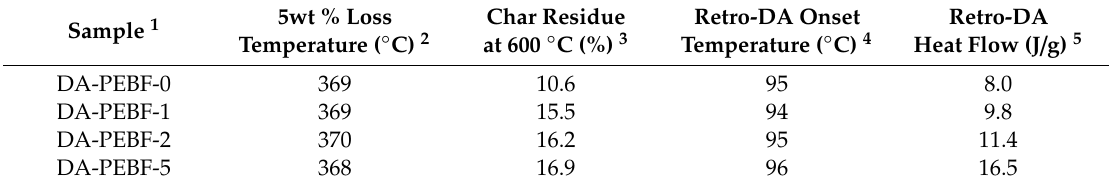
Figure 9. TGA profiles of DA-PEBF-0, DA-PEBF-1, DA-PEBF-2, and DA-PEBF-5 samples. The inset figure shows the detail thermograms within the weight percent range from 95% to 100%. Table 2. Thermal properties of PEBF / graphene / BMI hybrids with di ff erent loading of